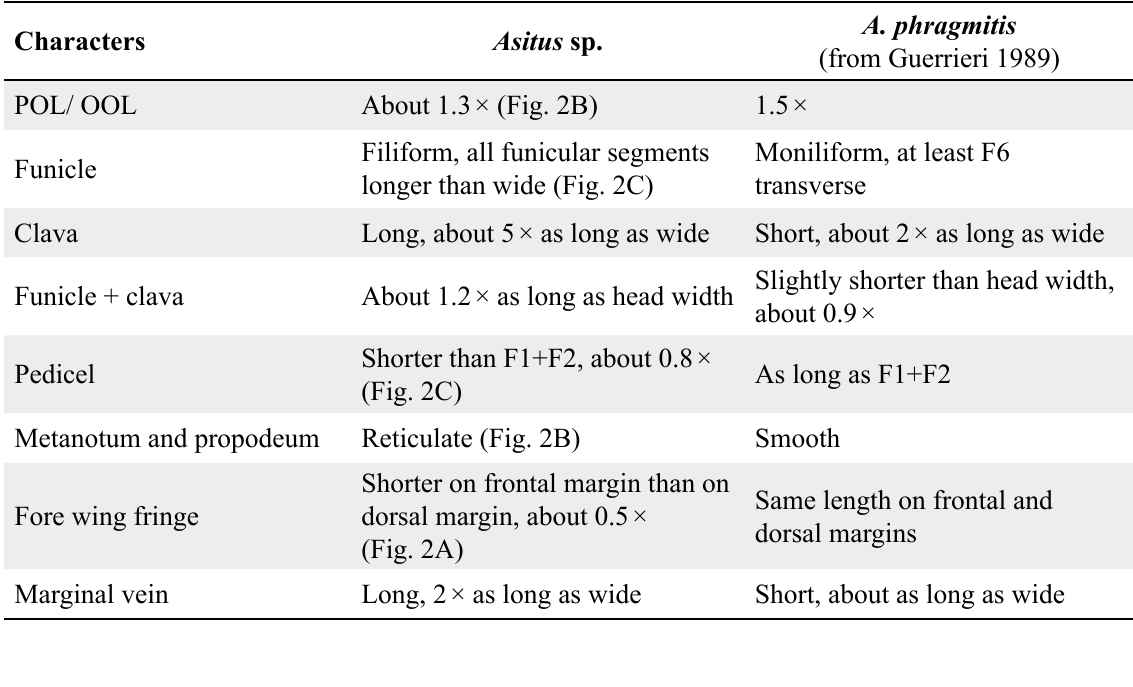
Table 2. Features distinguishing male Asitus sp. from A. phragmitis (Ferrière, 1955).